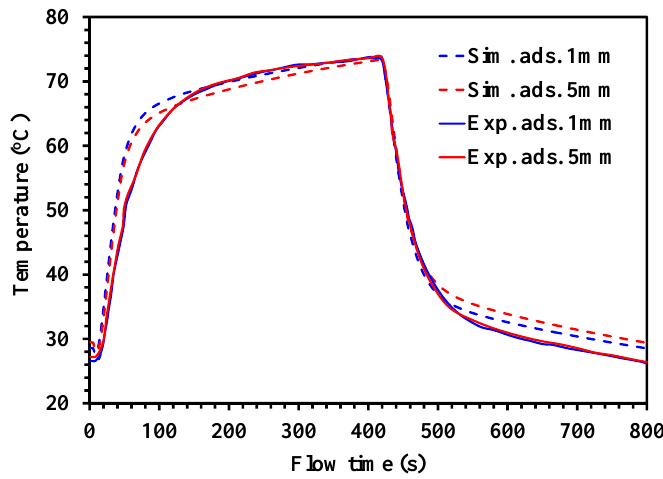
Figure 6. Simulated (dashed line) vs. experimental (line) temperature profiles at 1 (blue) and 5 mm (red) adsorbent thicknesses.